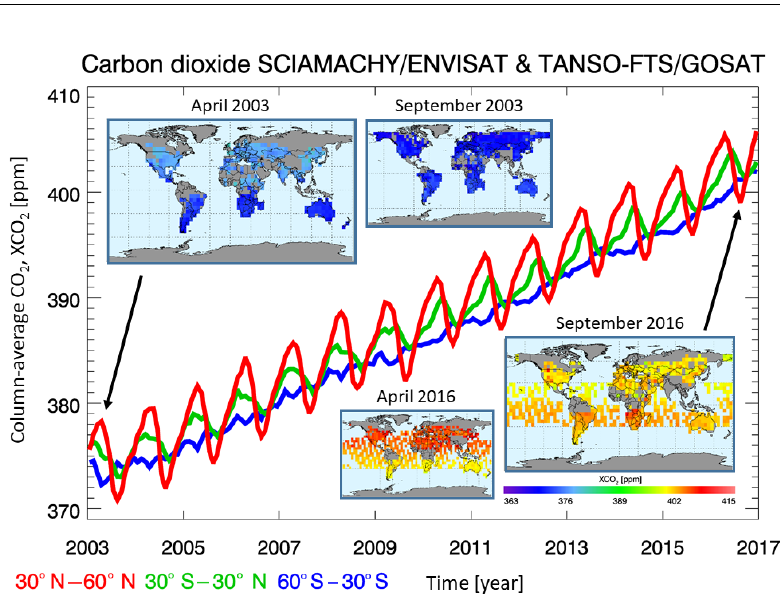
Figure 1. Time series and global maps of satellite-derived column-averaged dry-air mole fractions of carbon dioxide, i.e. XCO 2 . Data product Obs4MIPs version 3 is shown (O4Mv3) based on an ensemble of SCIAMACHY-ENVISAT (until April 2012) and TANSO-FTS-GOSAT (since mid-2009) individual sensor and individual sounding (level 2) data products. The three time series correspond to three latitude bands: 30–60 ◦ N (red), 30 ◦ S–30 ◦ N (green) and 60–30 ◦ S (blue). The maps in the top left show monthly XCO 2 for April and September 2003 (SCIAMACHY, land only) and the maps on the bottom right show monthly XCO 2 for April and September 2016 (TANSO-FTS, land and ocean